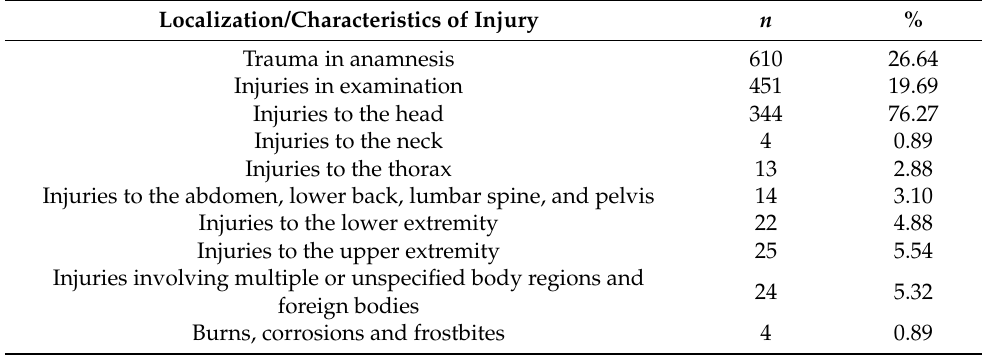
Table 5. Localizations and special characteristics of sustained traumatic injuries in patients under the influence of alcohol in the emergency department. Trauma in anamnesis refers to trauma reported by a patient, but not noticed by a physician during physical